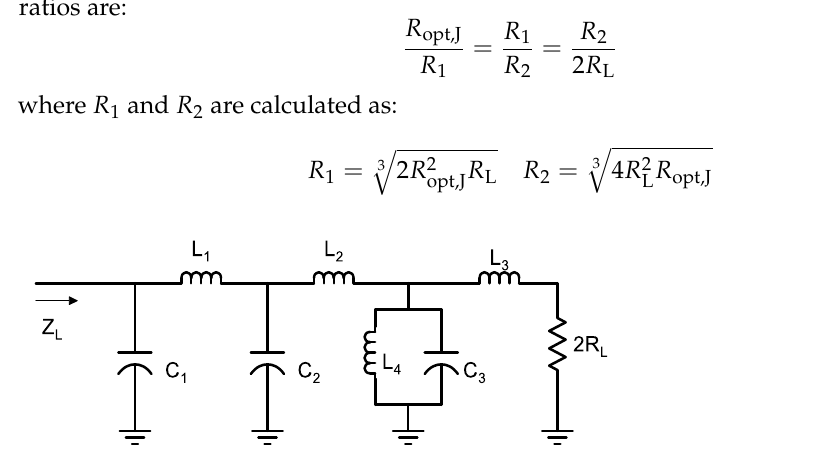
Figure 3. Low pass output matching